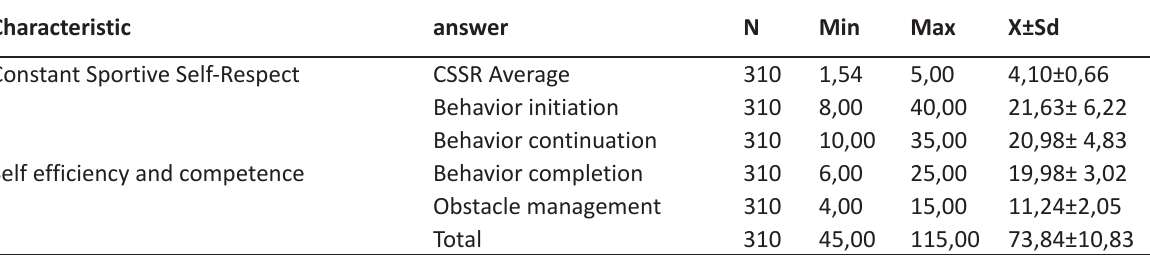
Table 2. Descriptive Statistics of Answers Given for Scales by Participants Characteristic